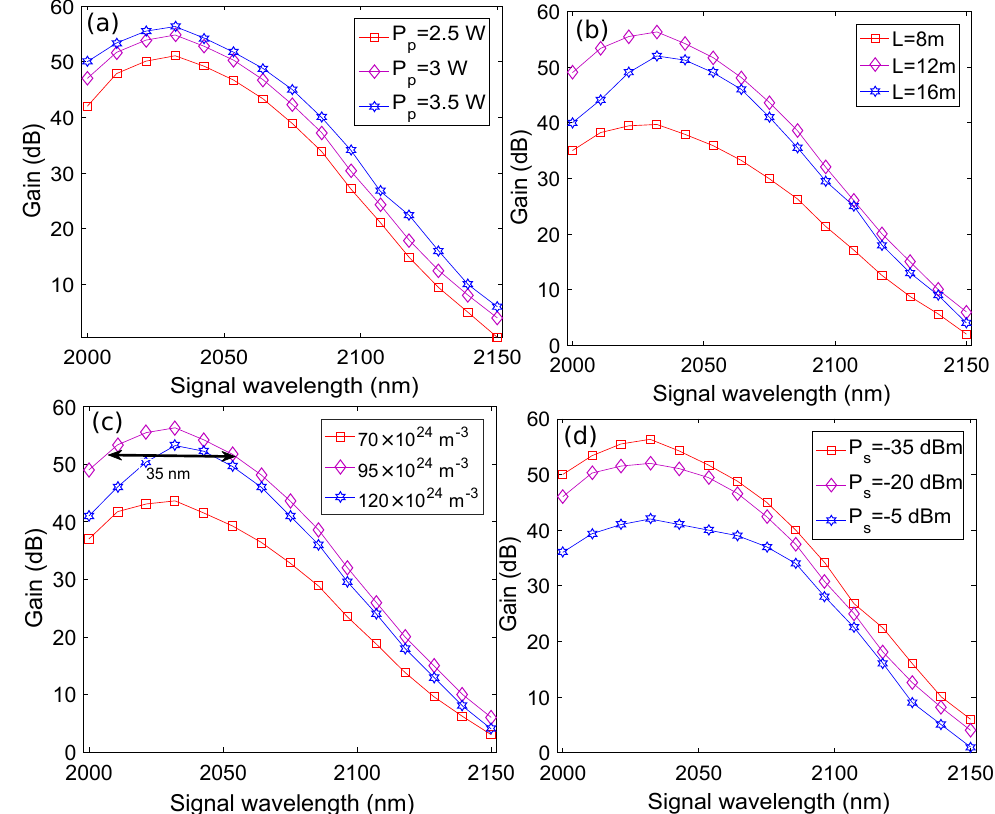
Figure 3. Gain of the HDFA plotted against variations in input signal wavelength for different values of ( a ) Pump power ( b ) HDF length ( c ) Ho 3 + concentration and ( d ) signal power.